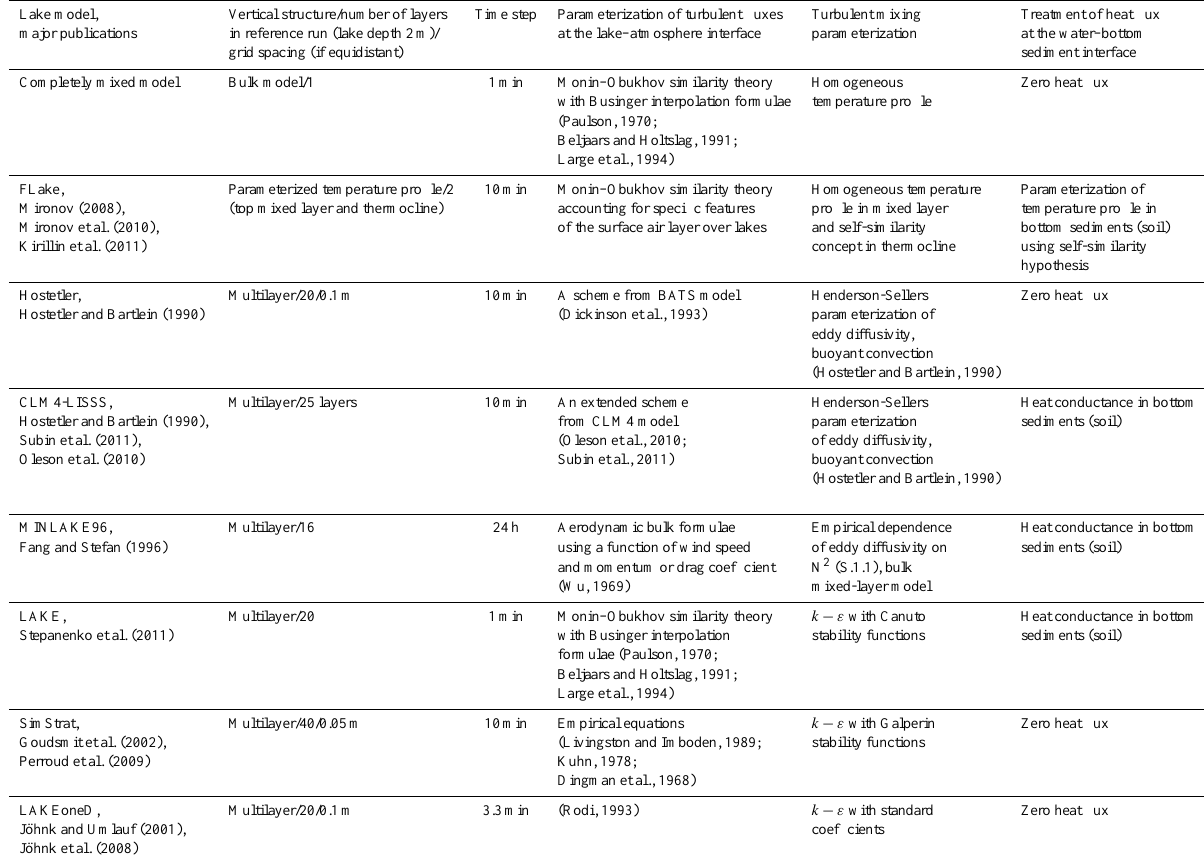
Table 1. The major features of lake models used in the intercomparison study. Lake